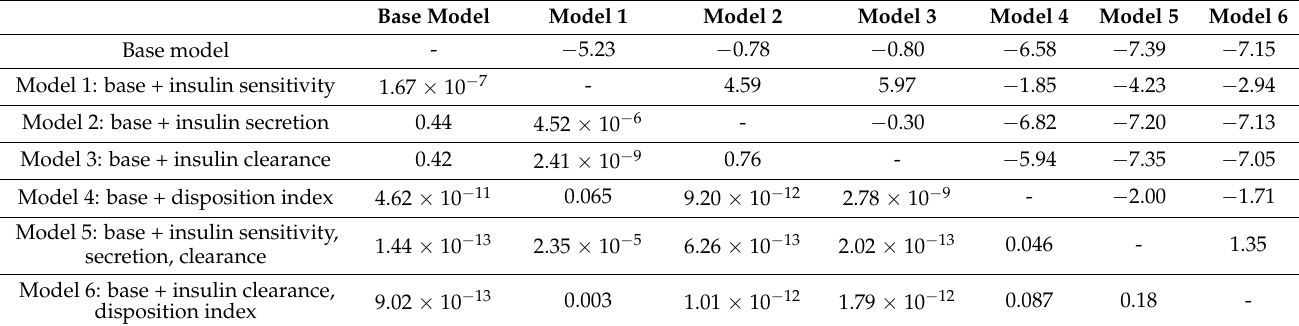
Table 4. Comparisons of AUROC values from different logistic regression models for